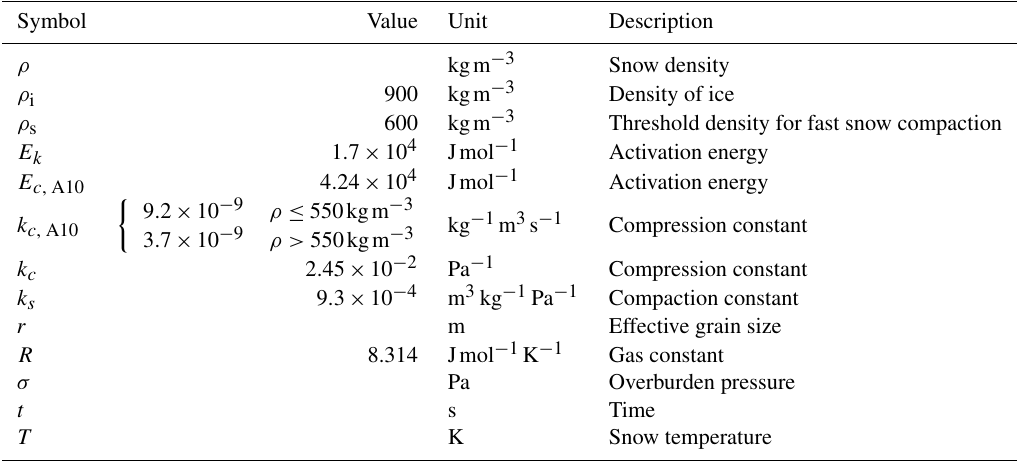
Table 1. List of variables in Eqs. (3) and (4). Symbol Value Unit Description